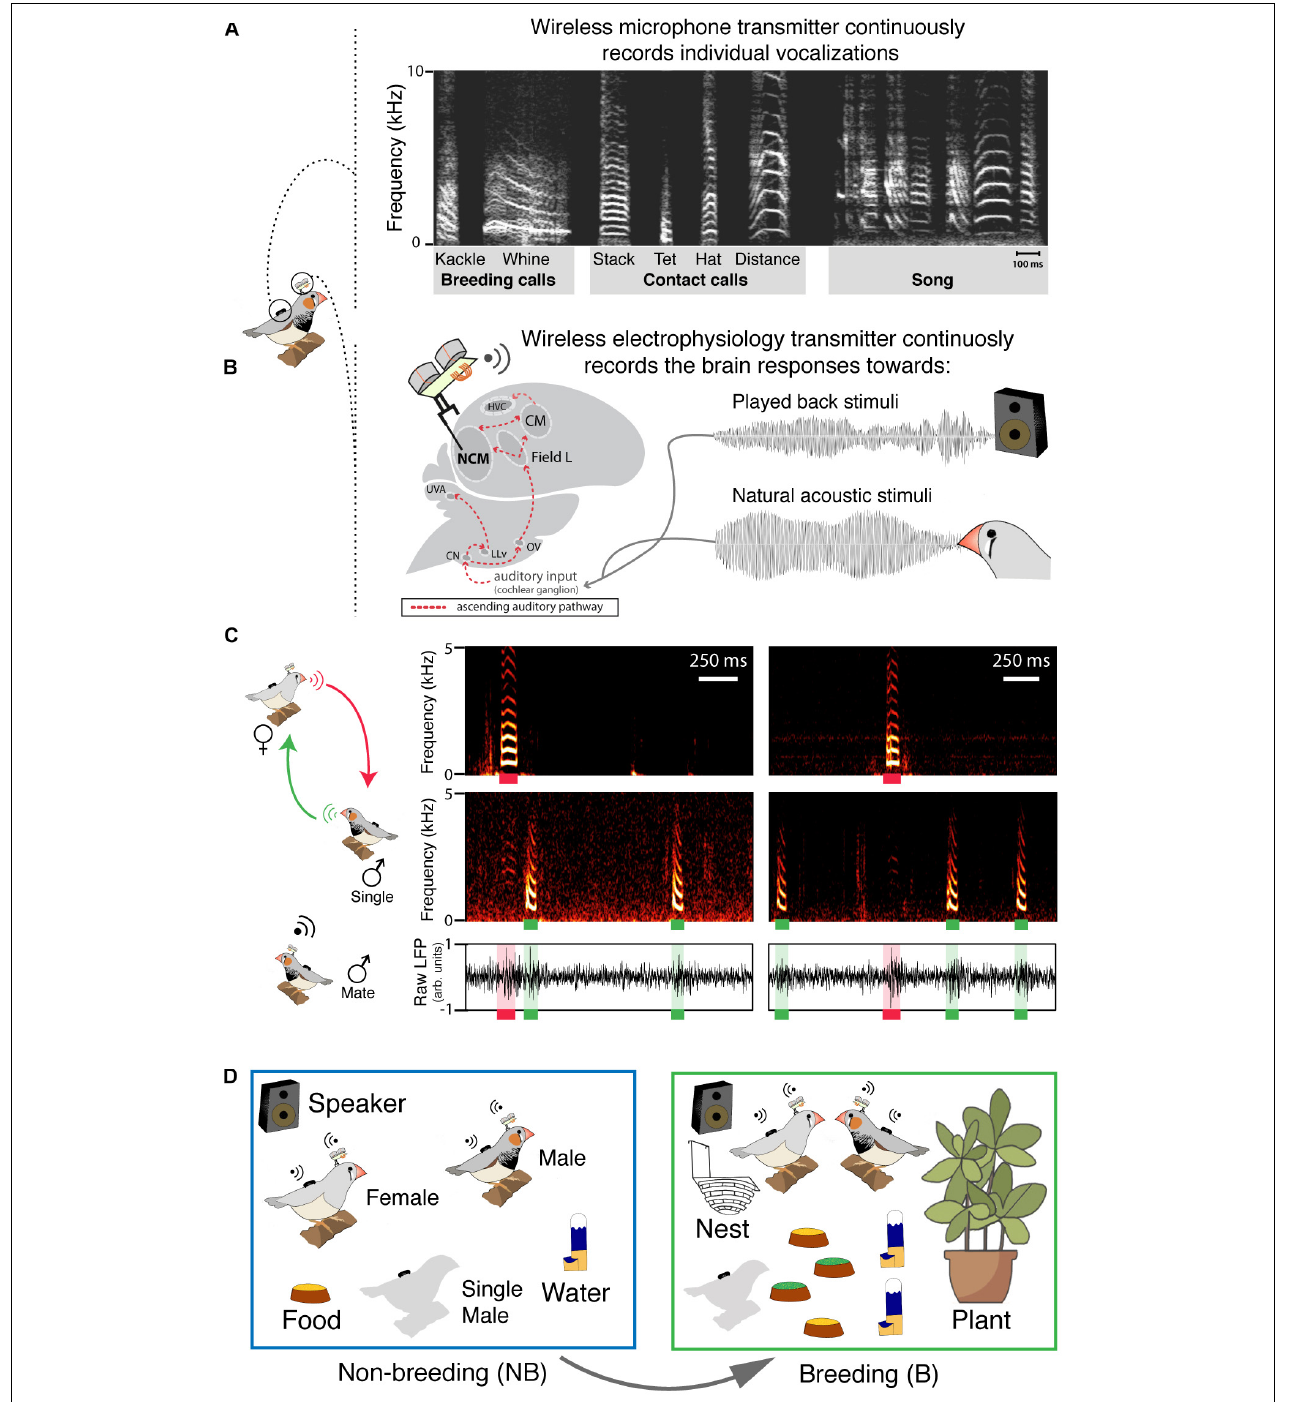
FIGURE 1 | Synchronized individual recordings of vocal and neural activity in group-living birds behaving freely. (A) Sonogram of the typical zebra finch repertoire: contact and breeding calls are produced by both sexes but only males sing. (B) Chronically implanted electrodes record from the caudomedial nidopallium (NCM); the ascending auditory pathway is shown in red (CN, cochlear nucleus; LLv, ventral lateral lemniscus; UVA, nucleus uvaeformis; Ov, nucleus ovoidalis; CM, caudal mesopallium; HVC, proper name). (C) Example of synchronous recording of a vocal interaction and NCMs neural responses within an experimental trio. The top, middle and bottom panels correspond, respectively, to vocalizations of the female (red), vocalizations of the extra-pair male (single; green) and the paired-male’s NCM LPF activity. Raw LFP corresponds to the 300 Hz threshold low pass filtered local field potential (LFP) response in NCM. (D) Sketch of non-breeding (NB) and breeding (B) life